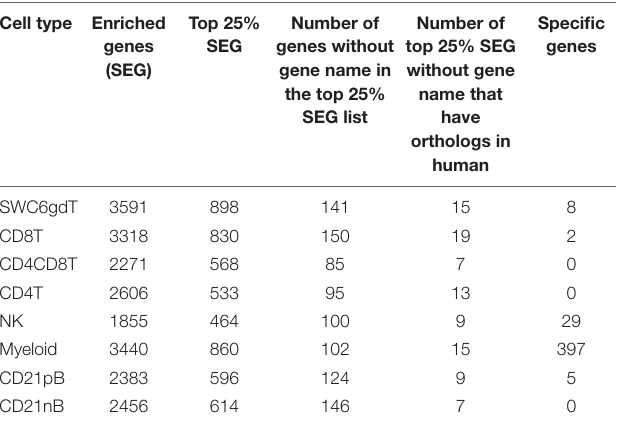
TABLE 2 | Cell type-enriched and cell type specific genes identified in pig sorted immune cells. Cell type Enriched